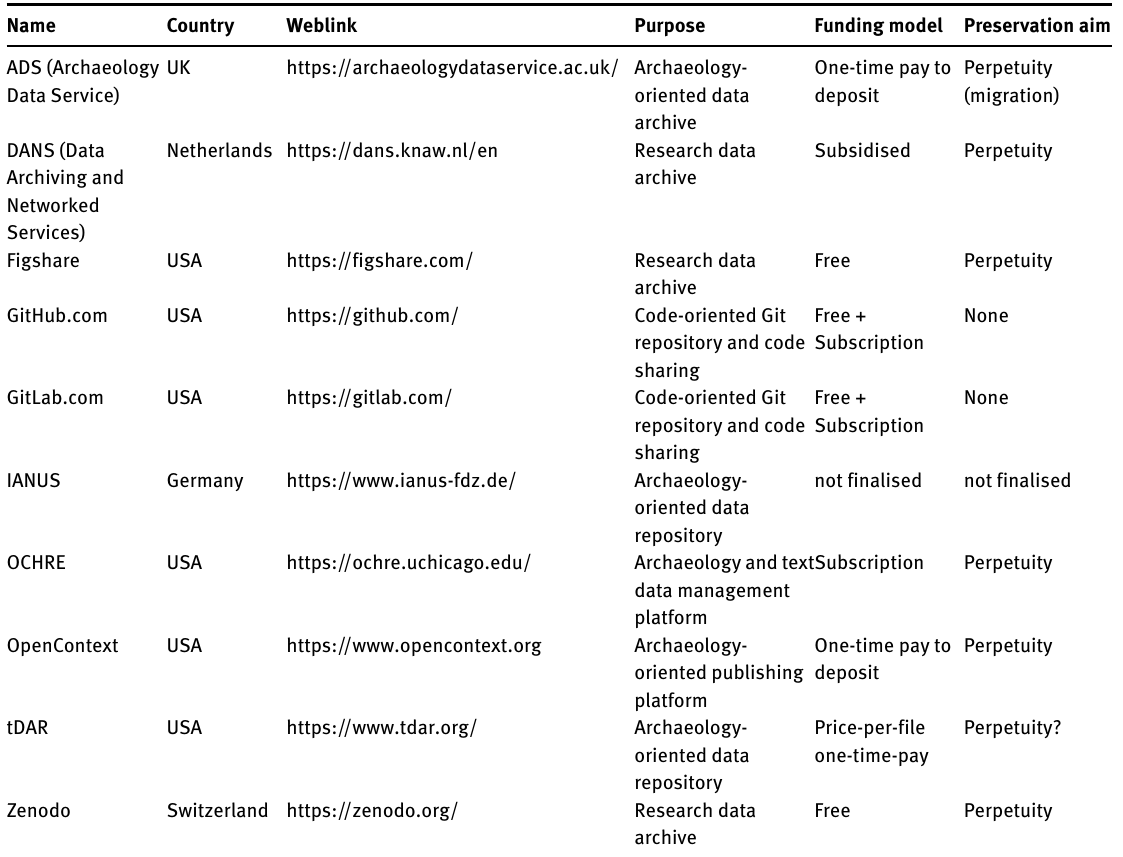
Table 3. Data and repository